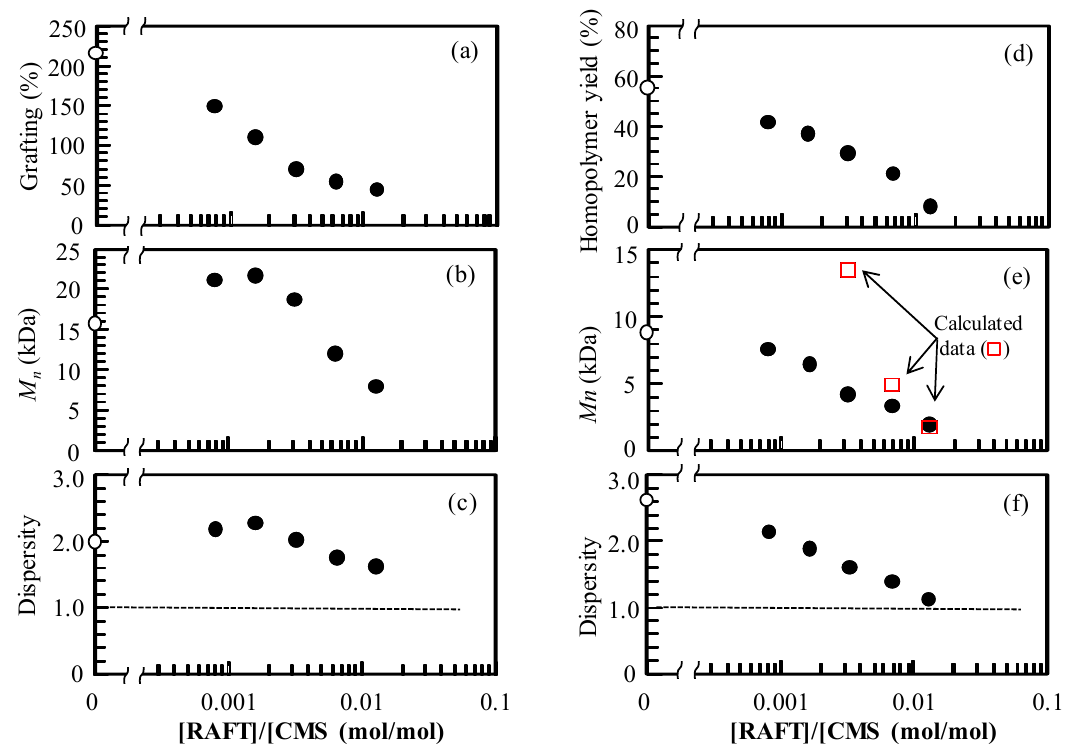
Figure 6. ( a ) Degree of grafting, ( b ) M n , ( c ) dispersity of the extracted poly(CMS) from grafted ETFE films, and ( d ) homopolymer yield, ( e ) M n , ( f ) dispersity of the homopolymer in the monomer solution as a function of the mole ratio of [RAFT]/[CMS]. Irradiation dose rate, 1.0 kGy/h; total irradiation dose, 50 kGy; [RAFT]/[CMS], 0.014.